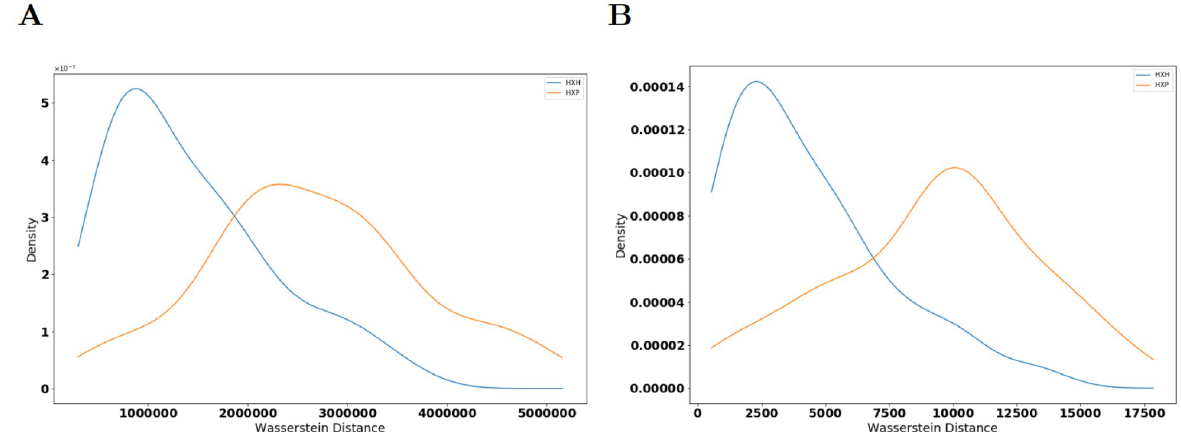
Fig 5. Distributions of Wasserstein distances between persistence diagrams. (A) Shows distributions of Wasserstein distance between H 0 - persistence diagrams for H × H (blue line) and H × P (orange line) pairs ( p = 8.77 × 10 − 15 , QFD = 0.173). (B) Shows distributions of Wasserstein distance between H 1 -persistence diagrams for H × H (blue line) and H × P (orange line) for the same pairs in (A) ( p = 3.04 × 10 − 14 , QFD = 0.219). Persistence diagrams are calculated from point clouds in the T-bet, Eomes, and Ki-67 axes. p-values are calculated from a 2-sided KS